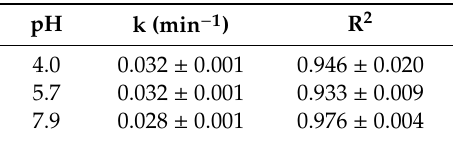
Table1. Pseudo-firstorderrateconstantsofthephotocatalyticdegradationofMERwiththeTiO 2 / Table 1. Pseudo-first order rate constants of the photocatalytic degradation of MER with the